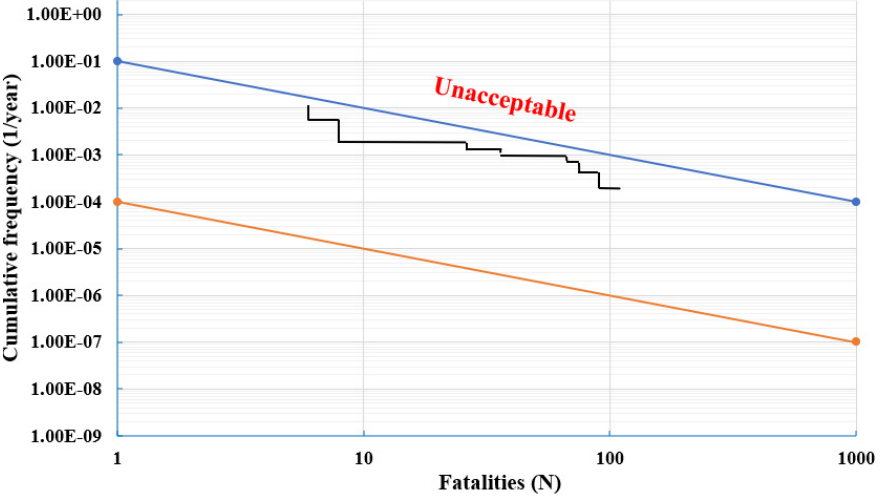
Figure 9. F/N curve for scenarios with 0 m/s ventilation velocity.